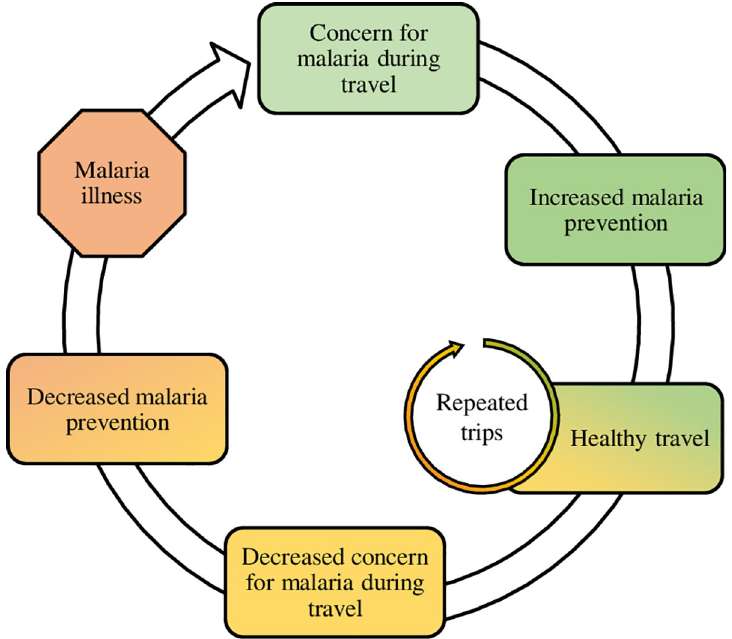
Fig 5. A cross-sectional, multi-setting survey of malaria prevention knowledge, attitudes, and practices among US travelers to sub-Saharan Africa: Conceptual health behavior framework with hypothesized reduction in risk perception and use of malaria prevention upon repeated trips of travelers visiting friends and